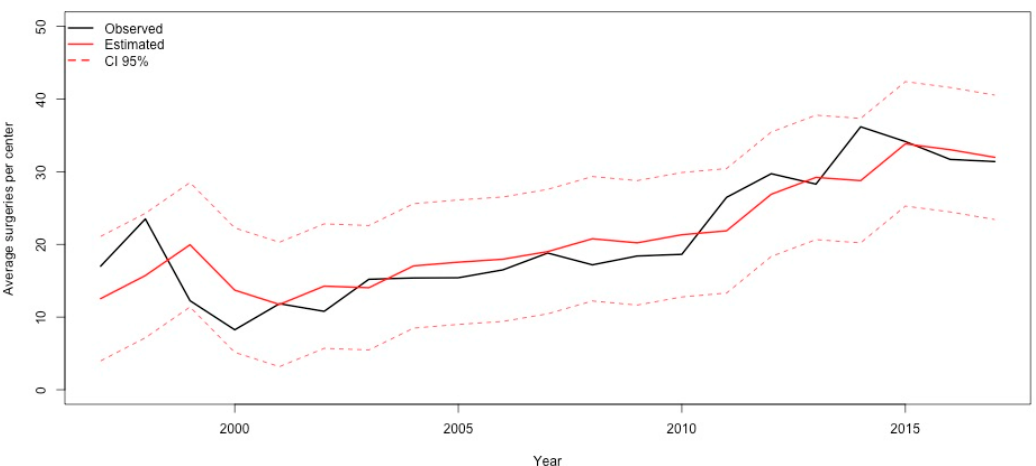
Figure 2. Time–series showing the observed (solid black line) and estimated (solid red line) average surgical workload according to the year of surgery in adult patients with congenital heart disease. Data shown as the average number of procedures per center. The 95% confidence interval is reported as dashed red line.